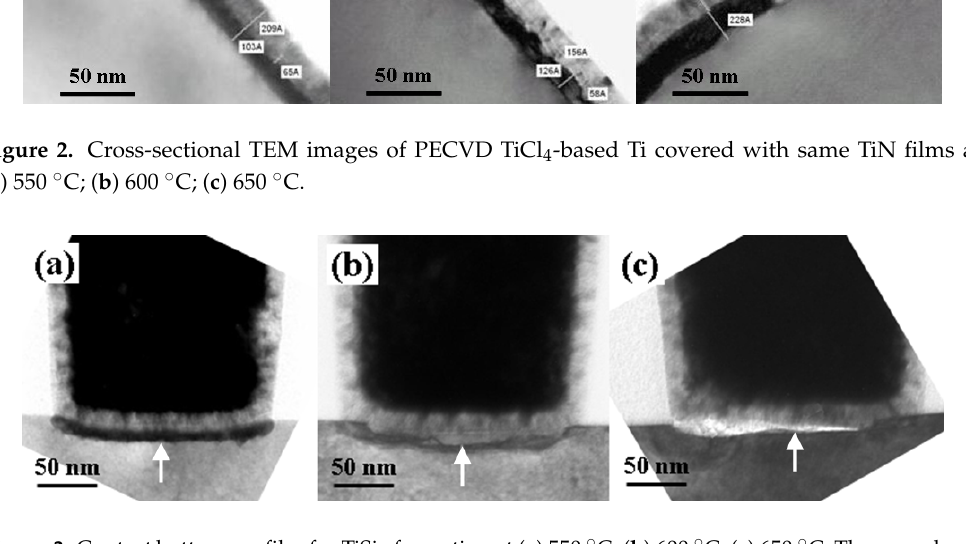
Figure 3. Contact bottom profiles for TiSi x formation at ( a ) 550 °C; ( b ) 600 °C; ( c ) 650 °C. The arrowhead represents the TiSi x formation